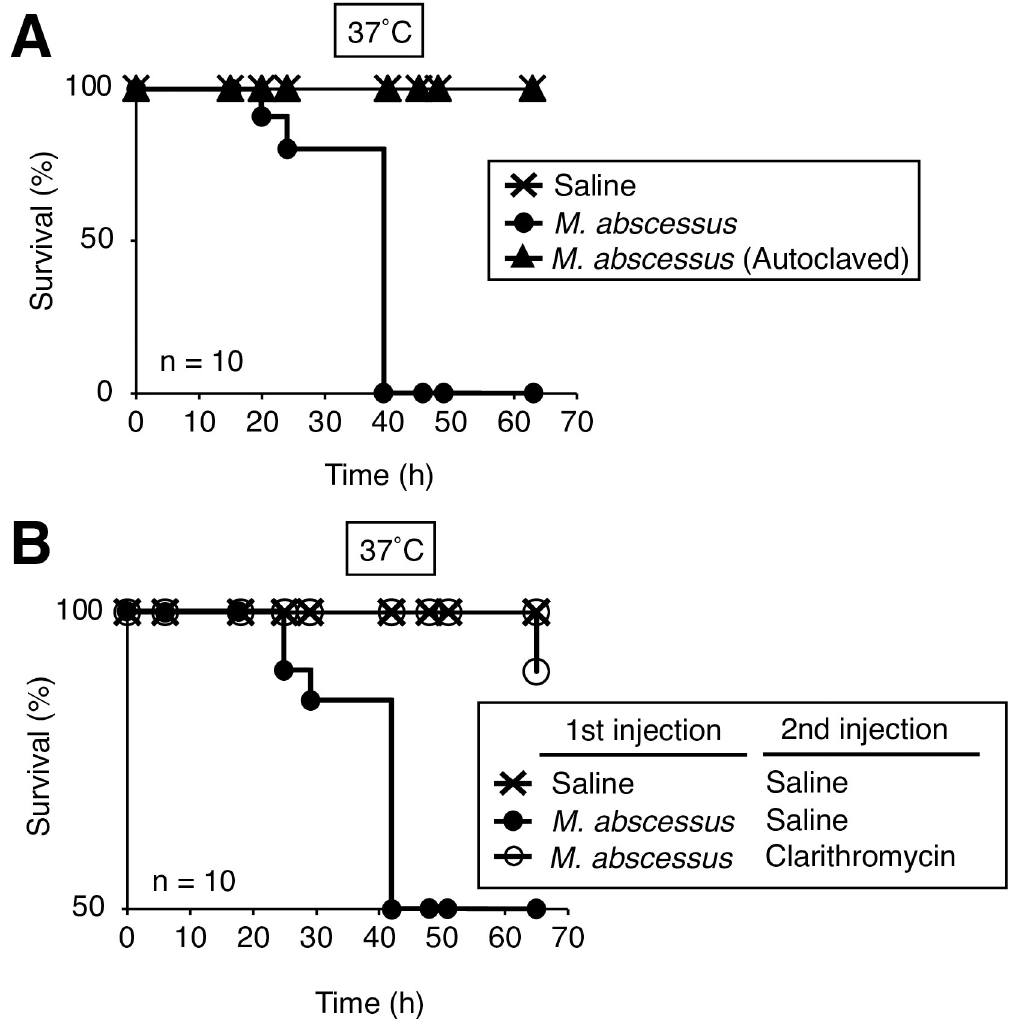
Fig 4. Effects of autoclaved cells and antibacterial treatment in silkworms infected with M . abscessus subsp. abscessus . ( A ) Silkworms were injected with either saline (50 μ l), M . abscessus subsp. abscessus ATCC19977 cell suspension (1.1 x 10 7 cells per 50 μ l), or autoclaved M . abscessus subsp. abscessus ATCC19977 cell suspension and incubated at 37˚C. Ten silkworms were used per group. ( B ) Silkworms were injected with either saline (50 μ l) or M . abscessus subsp. abscessus ATCC19977 cell suspension (6.3 x 10 7 cells per 50 μ l) followed by clarithromycin (25 μ g g -1 larva). The number of surviving silkworms following incubation at 37˚C was measured for 66 h. Statistically significant differences between groups were evaluated using a log-rank test based on the curves by the Kaplan-Meier method. Ten silkworms were used per group.